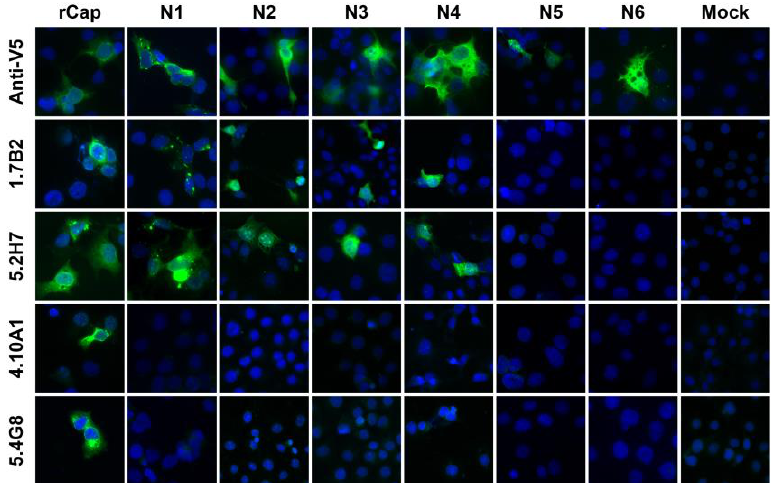
Figure 4. Monoclonal antibody reactivity by Immunofluorescence Assay (IFA) with acetone-fixed monolayers of COS-7L cells transfected with full-length rCap or N-truncated constructs. Cells were probed with respective mAbs before incubation with an anti-mouse Alexa Fluro 488 conjugate (green) and Hoechst 33,342 (blue) for nuclear staining. Two mAbs representing each group were chosen for this experiment: Group 1—1.7B2, 5.2H7; and Group 2—4.10A11, 5.4G8. Images were captured at 400× or 1000× magnification.